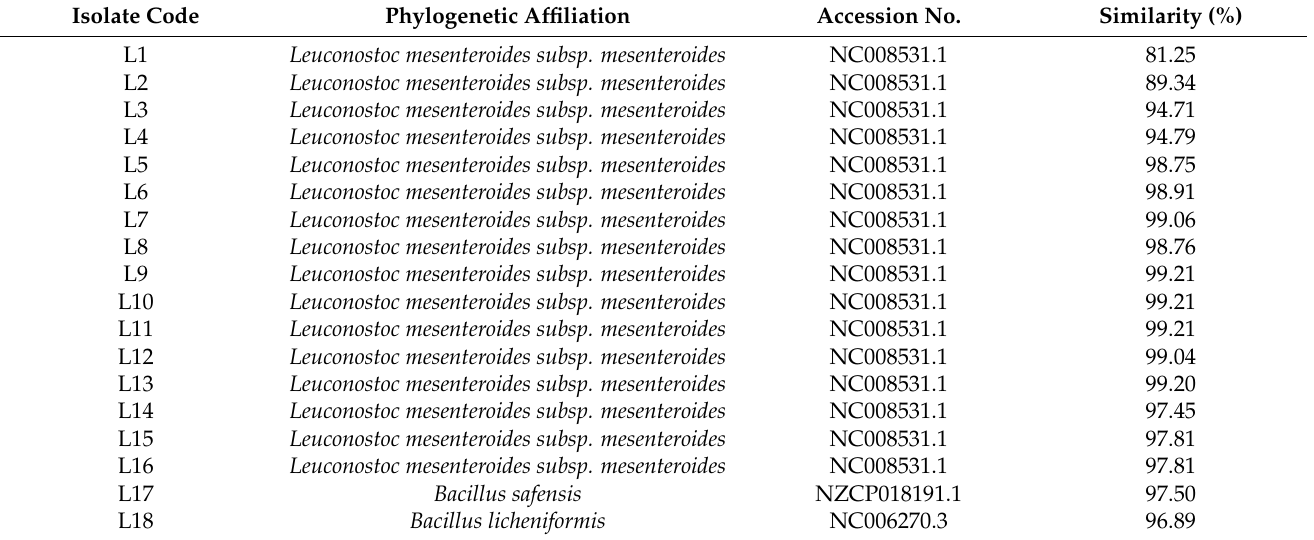
Table 1. Identification of LAB isolates from spontaneously fermented carrot and ginger brine by sequencing the 16S